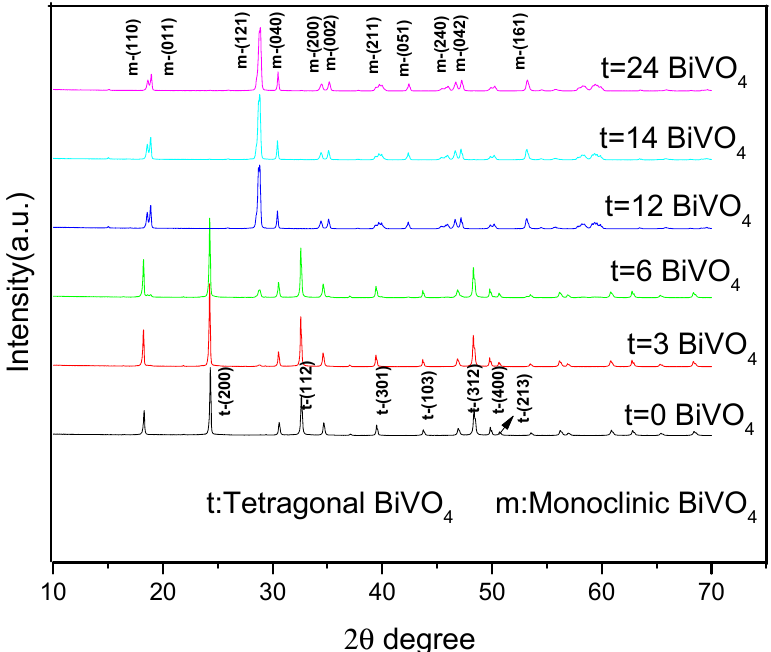
Figure 2. XRD spectra of the BiVO 4 prepared under different hydrothermal time conditions. In order to better clarify the influence degrees of the hydrothermal times on each crystal plan growth of the BiVO 4 , (011) was taken as the internal standard of the diffraction peak to normalize the XRD diffraction peak intensity. Table 1 lists the (121)/(011) and (040)/(011) intensity of each diffraction peak. It was observed that when t = 6 h, the (121) and (040) diffraction peaks were relatively weak, and the (121)/(011) and (040)/(011) values were 0.215 and 0.408. However, with the increases in the hydrothermal times, the (121) and (040) diffraction peaks were gradually strengthened, which indicated that certain hydrothermal times were conducive to the formations of the (121) and (040) diffraction peaks. In the m-BiVO 4 standard PDF card (JCPDS No. 140688), the (040)/(121) intensity ratio is 0.25, which has been taken as the standard. When t = 6 h, the (040)/(121) had a value of 1.897, which indicated a weak (121) diffraction peak intensity. Then, as the hydrothermal times increased, the (040)/(121) values were determined to be 0.261, 0.296, and 0.307, which were close to the (040)/(121) values of 0.25 in the m-BiVO 4 standard PDF card (JCPDS No. 140688). In this study, when t = 12 h, the value of 0.261 was almost approached, which confirmed that that particular hydrothermal time was favorable for the formation of m-BiVO 4 diffraction peaks. However, when t was 14 and 24 h, it was observed that the (040)/(121) values displayed slightly increasing trends, indicating that when